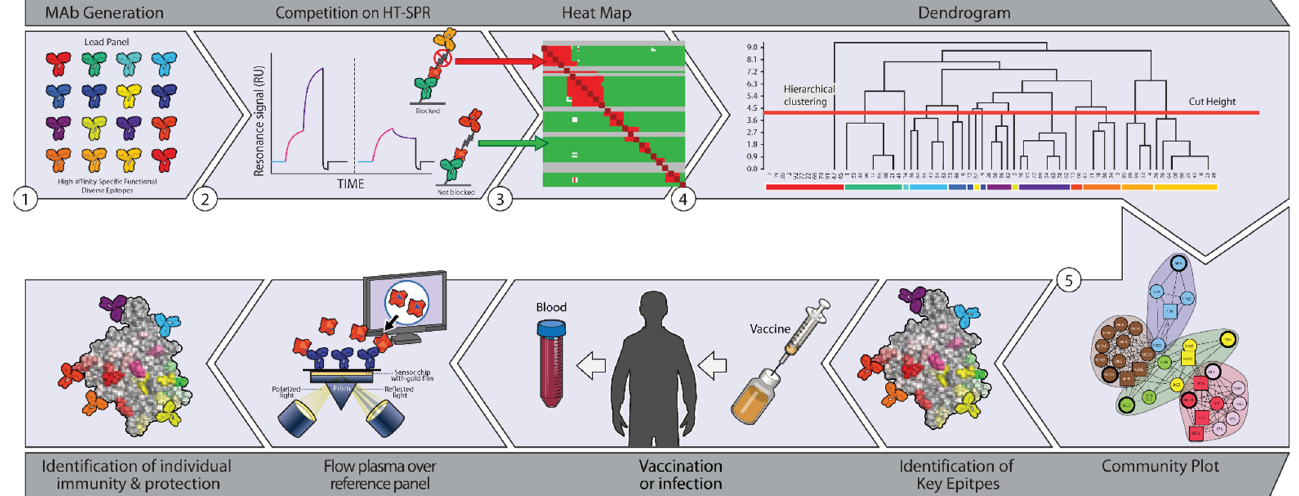
Figure 2. Steps in epitope characterization assays for characterizing the vaccine-induced humoral response. Step 1. Antibodies to microbial protein targets are generated. Step 2. Epitope binning assays are performed using monoclonal antibodies generated in step 1. Step 3. A heat map is generated from the epitope binning, or cross-competition assays. Step 4. Dendrogram from the heat map is generated. Step 5. A community plot is generated from the dendrogram, which groups antibodies by their epitope binding regions. Step 6. A panel of antibodies with broad coverage of all the epitopes on microbial targets is generated. Step 7. Patients are immunized, and plasma at time points are collected. Step 8. Plasma flows over the reference panels from step 6 on a biosensor where the bound epitopes are identified. Step 9. The patient’s humoral response by epitope is generated, identifying which epitopes have coverage. Neutralizing sites or profiles at the epitope level can then be identified by comparing them to neutralization assay results (not in a one-on-one